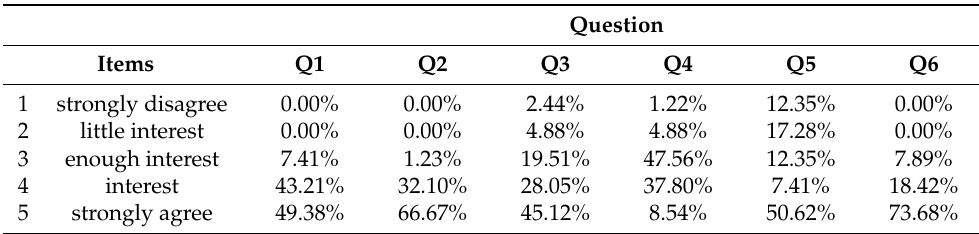
Table 3. A percentage representation of the frequency distribution of items on the Likert scale according to Table